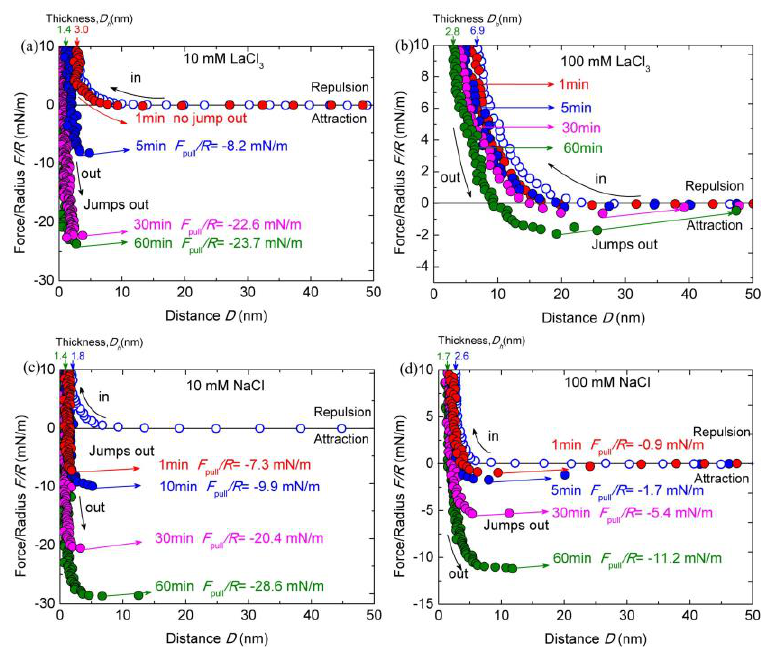
Figure 5. Interaction forces F / R as a function of surface separation D between two chitosan-adsorbed mica surfaces in 100 mM HAc buffer with 10 mM LaCl 3 ( a ), 100 mM LaCl 3 ( b ), 10 mM NaCl ( c ), and 100 mM NaCl ( d ), pH = 3.2. The open and closed symbols indicate the approach and separation of the two surfaces, respectively.